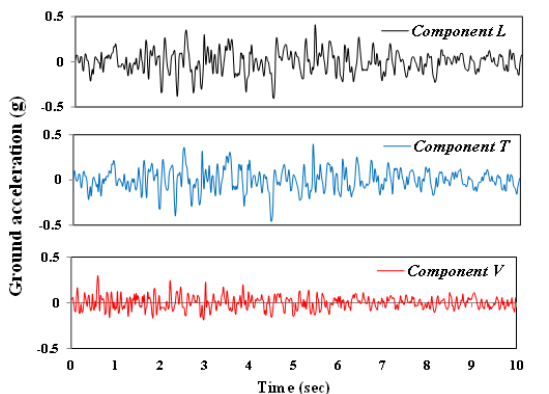
Figure 10. TABAS earthquake components recorded in TABAS sta- tion (L: stream direction, T: cross section direction,